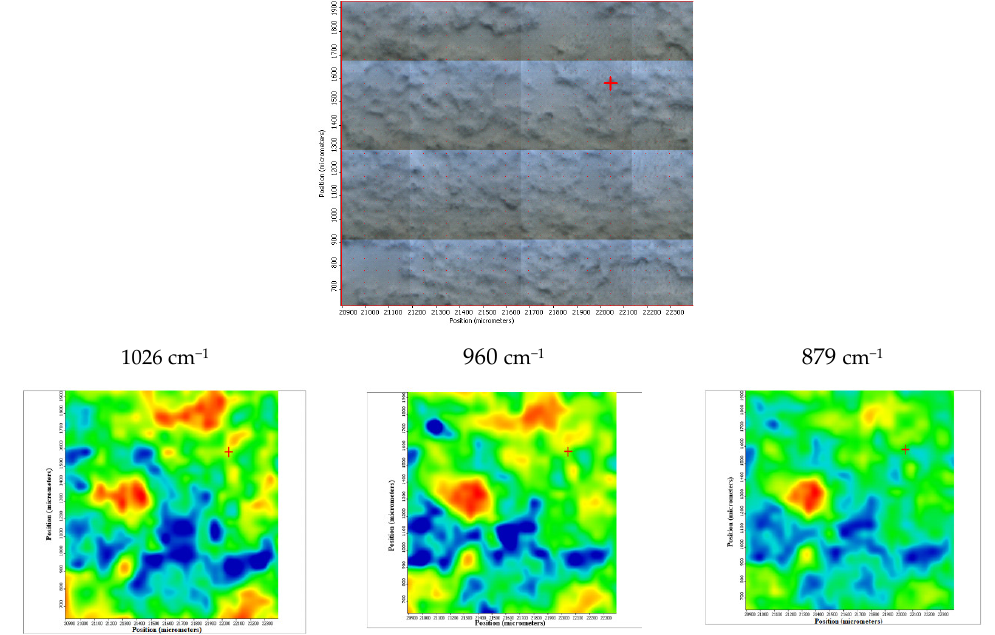
Figure 9. FTIR chemigram maps of the coated ZMX 410 alloy. In the upper part, a dark field optical image, corresponding to the investigated area, is presented. In the lower part, false colour maps with the indicated reference bands are shown. The chemigram scale bars are expressed in μm.